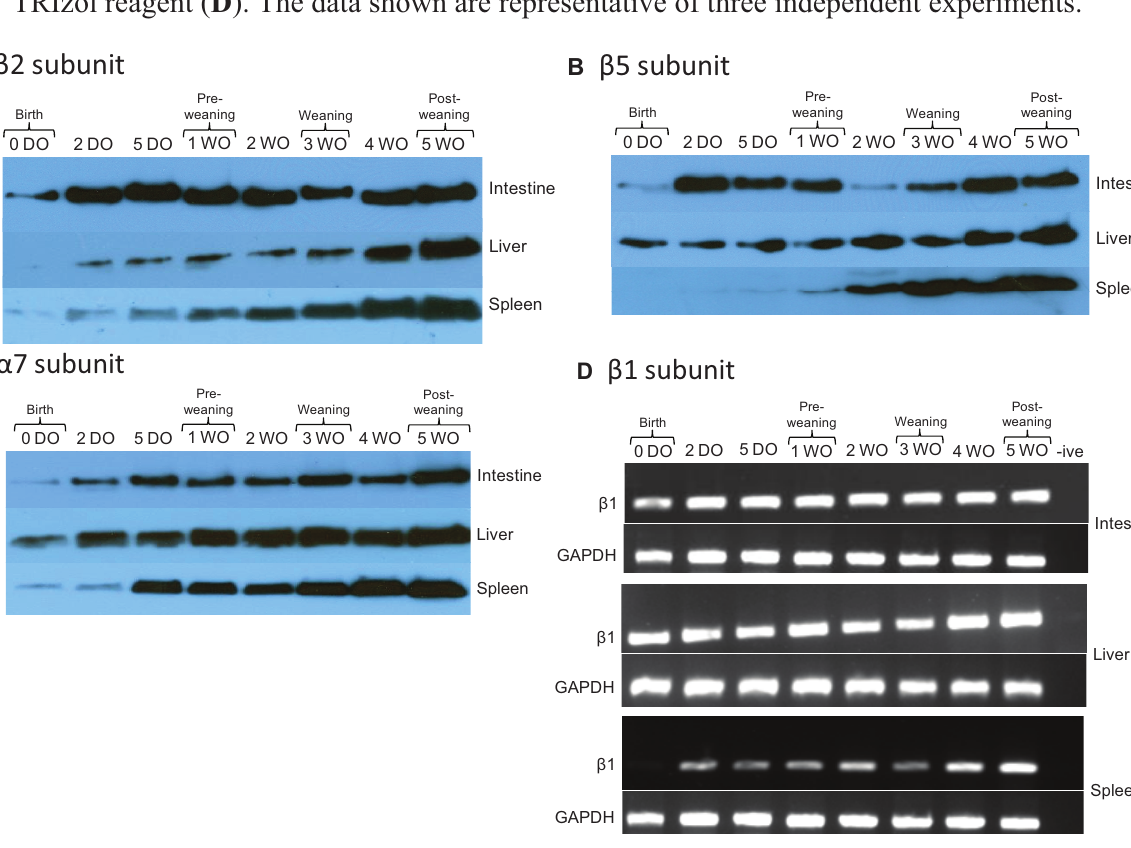
Figure 2. Expression of “core” 26S proteasome subunits during development in